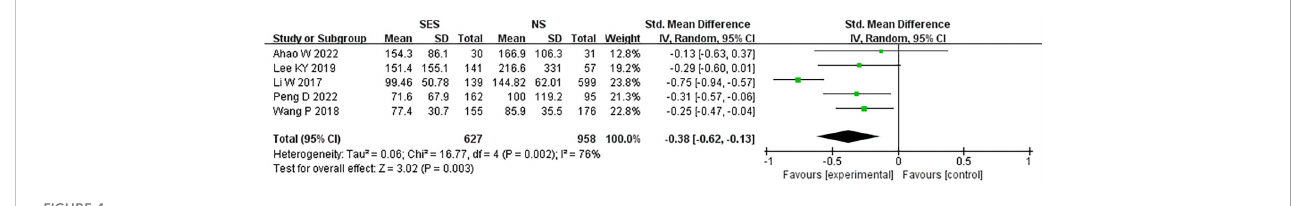
FIGURE 4 Blood loss. NS: new site.